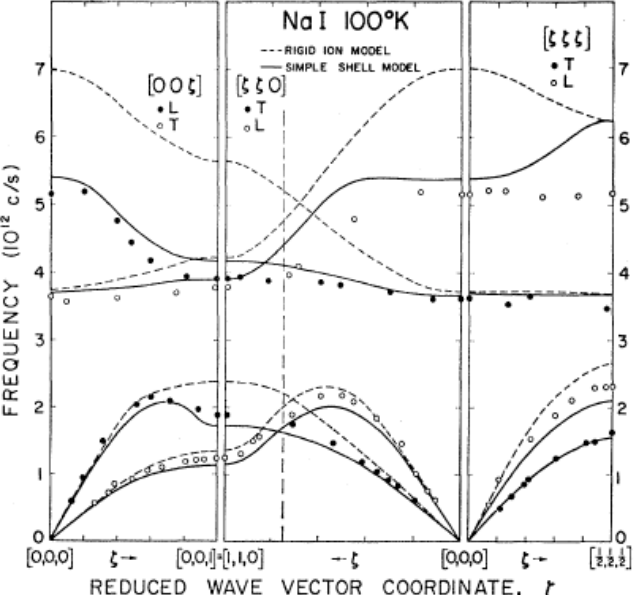
Figure 26. The phonon dispersion relations in sodium iodide measured near 100 K. The measurements are compared with calculations based on the rigid ion (dashed) and simple shell (continuous) models. The broken vertical line indicates the [110] zone boundary. This figure is taken from Figure 1 of ref. [72]. Copyright by the American Physical Society.